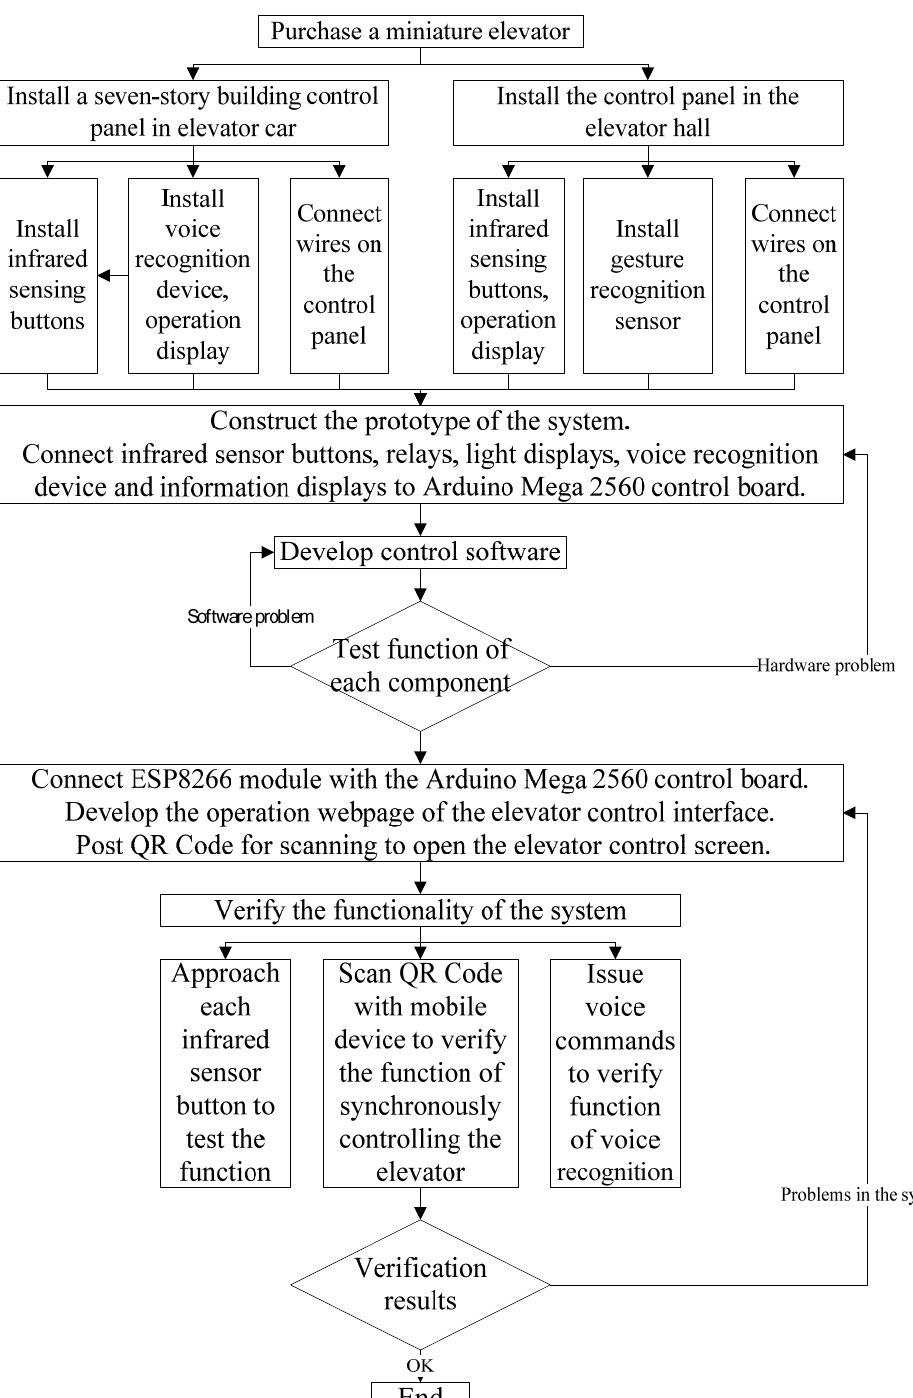
Figure 5. Flow chart for developing the contact-free epidemic prevention elevator.